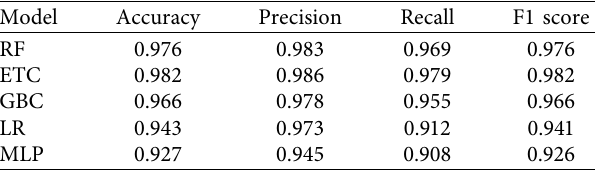
Table 12: Results of machine learning models with CR data